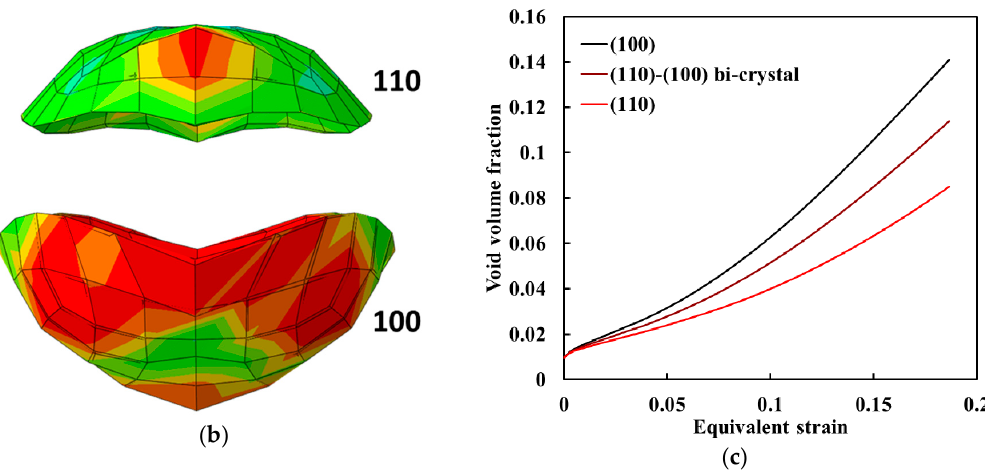
Figure 8. ( a ) a void located at the grain boundary between (110) and (100) crystal after deformation of a macroscopic strain 0.15: ( a ) view on XY and YZ planes; ( b ) 3D representation of the void by drawing one layer elements surrounding the void after the deformation; ( c ) evolution of void volume fraction (or equivalently the void growth rate) in (110)-(100) bi-crystal. The plots (110) and (100) represent the void volume fraction of each portion in the bi-crystal. The region with the red color represents highly deformed regions.